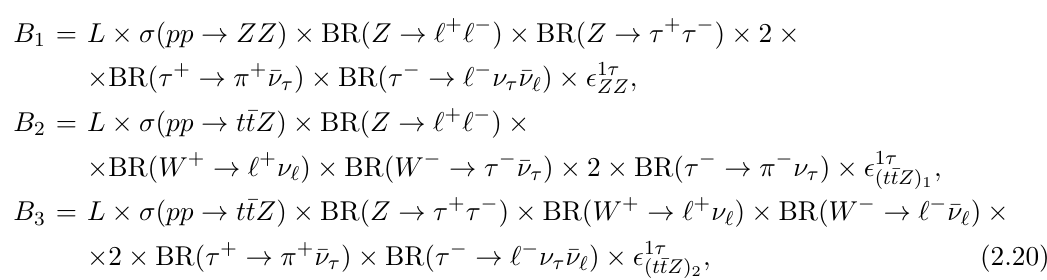
Figure 4 . Signi(cid:12)cance of pp ! H ++ H (cid:0)(cid:0) ! (cid:28) (cid:6) ‘ (cid:6) ‘ (cid:7) ‘ (cid:7) with (cid:28) (cid:6) ! (cid:25) (cid:6) luminosity (fb (cid:0) 1 ) for NH and IH at 14 TeV LHC. We assume M